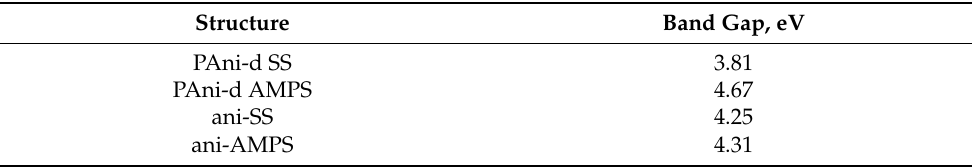
Table 3. Band gap of ani-SS, ani-AMPS, PAni-d SS, and PAni-d AMPS.